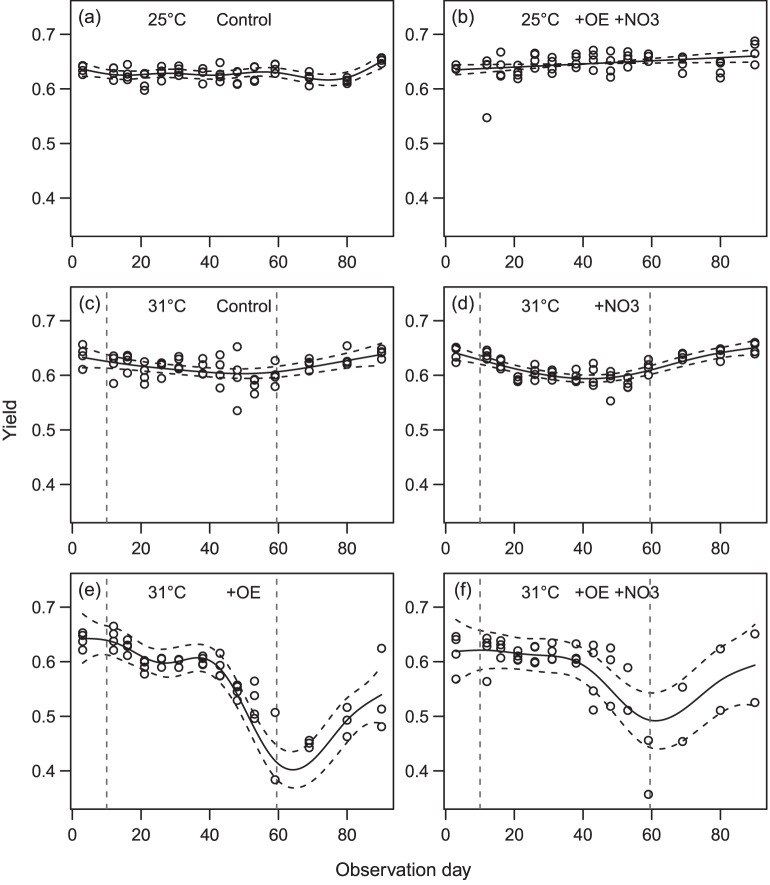
Effects of organic enrichment and nitrate on the fluorescent yields of heat-stressed and control M. tuberculosa.Time series of the fluorescence yields in Montipora tuberculosa. For details see the legend for Fig. 2. In this species, heat stress (31.2°C) was applied between Days 10 and 59.